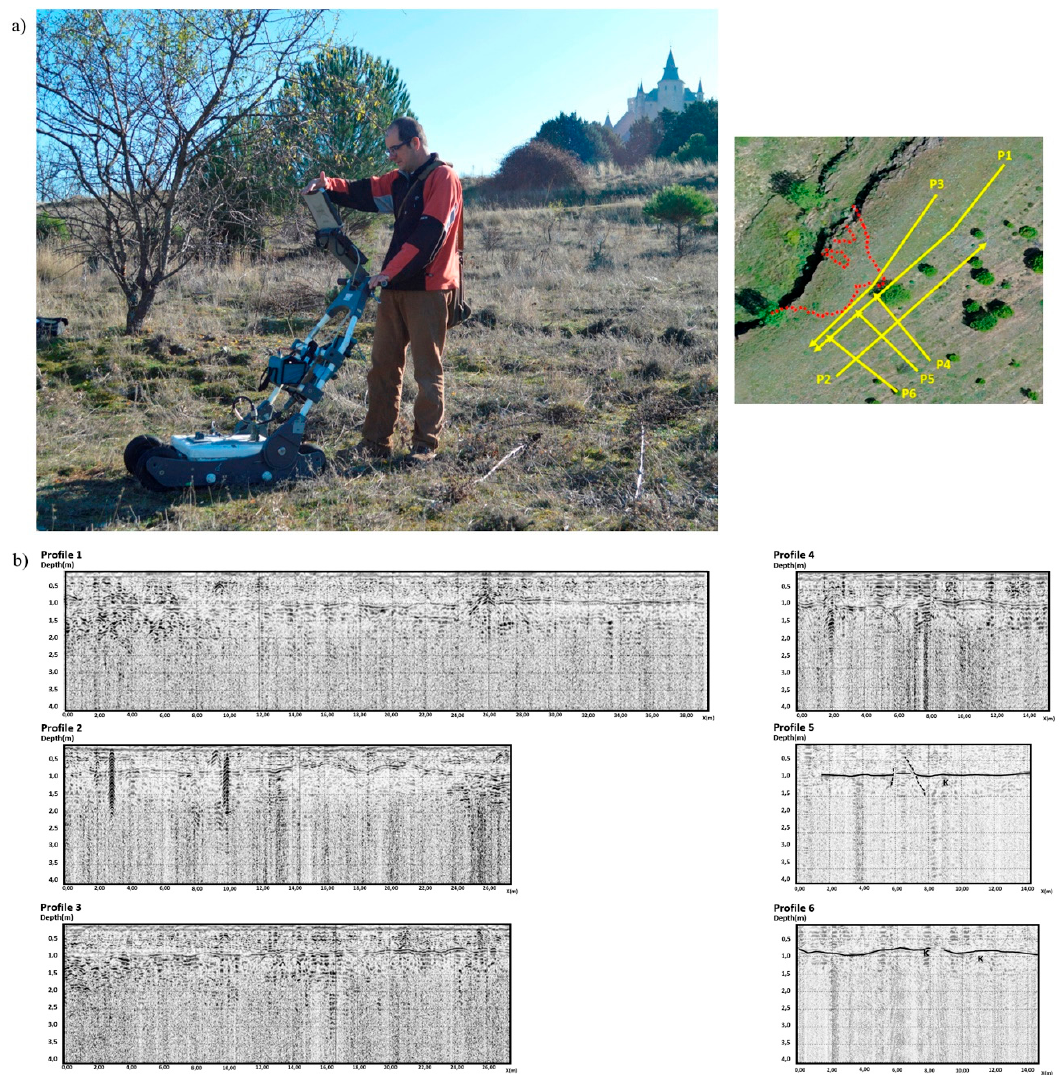
Figure 6. Ground Penetrating radar campaign: ( a ) general view of the sensor used and; ( b ) radargrams obtained.